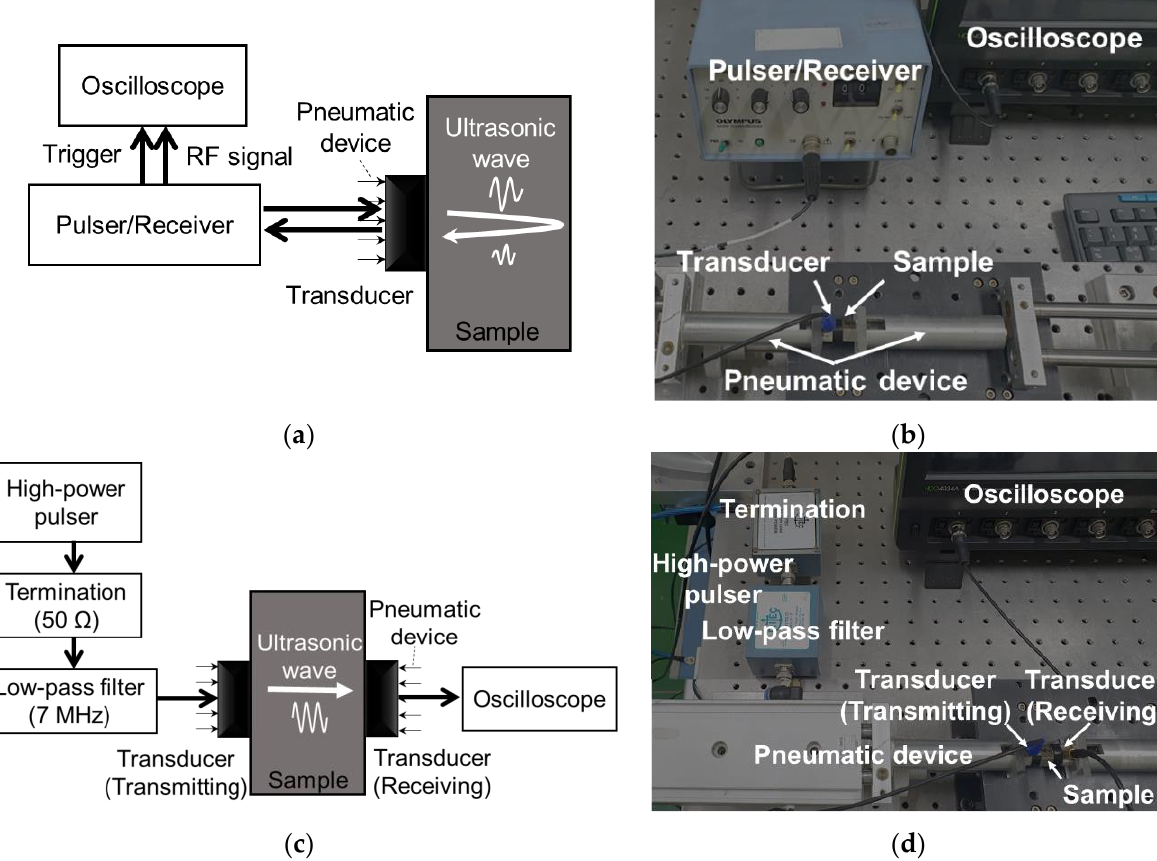
Figure 2. Schematics ( a , c ) and photographs ( b , d ) for the PE and TT modes,